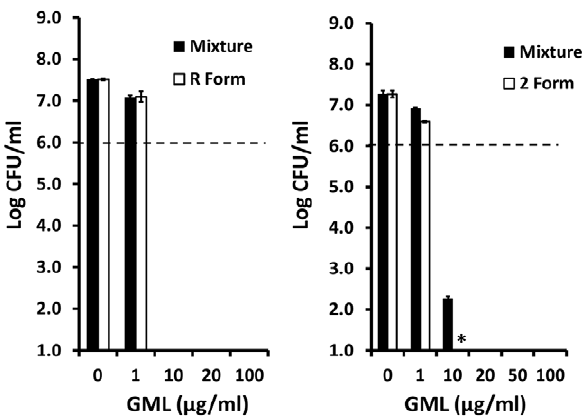
Figure 10. Ability of R versus S and 1/3 versus 2 forms of GML to inhibit growth of Streptococcus pyogenes 594. R form and mixture of R and S forms of GML and 2 position lauric acid versus mixture of 1/3 and 2 position lauric of GML were incubated with Streptococcus pyogenes 594, a highly susceptible organism to GML, for 24 hours. Plate counts were used to determine GML killing. * indicates the mean for the 2 form of GML is significantly different from the mixture at p , 0.001. Dashed line indicates starting inoculum